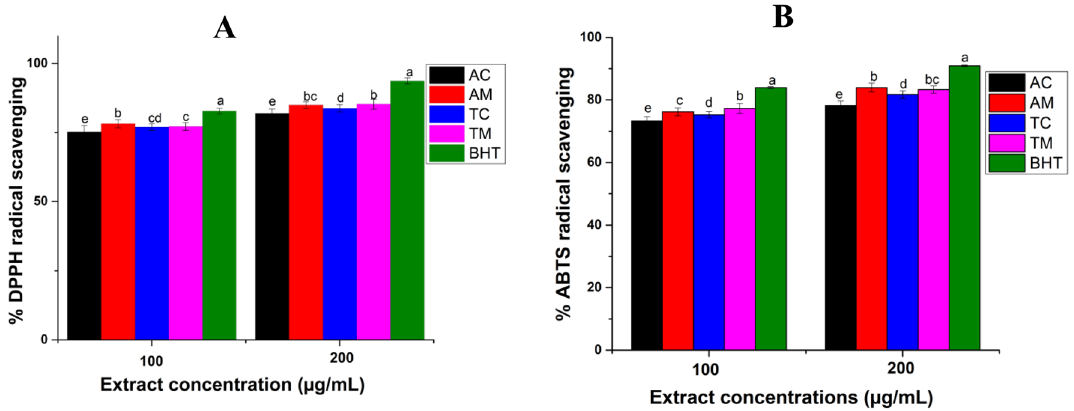
Fig. 1 A DPPH and B ABTS radical scavenging activity of chloro- form (AC and TC), and methanol (AM and TM) extracts of A. bella- donna and T. linearis respectively. BHT: butylated hydroxytolune.